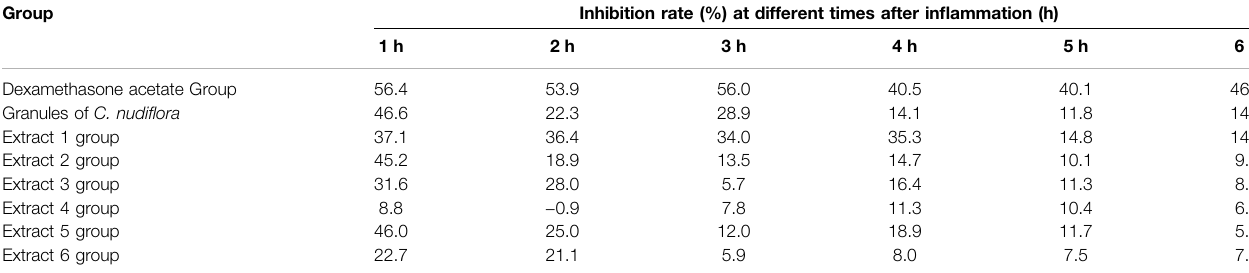
TABLE 2 | Effect of different C. nudi fl ora extracts on inhibition rate of carrageen-induced swelling of the foot in rats. Group